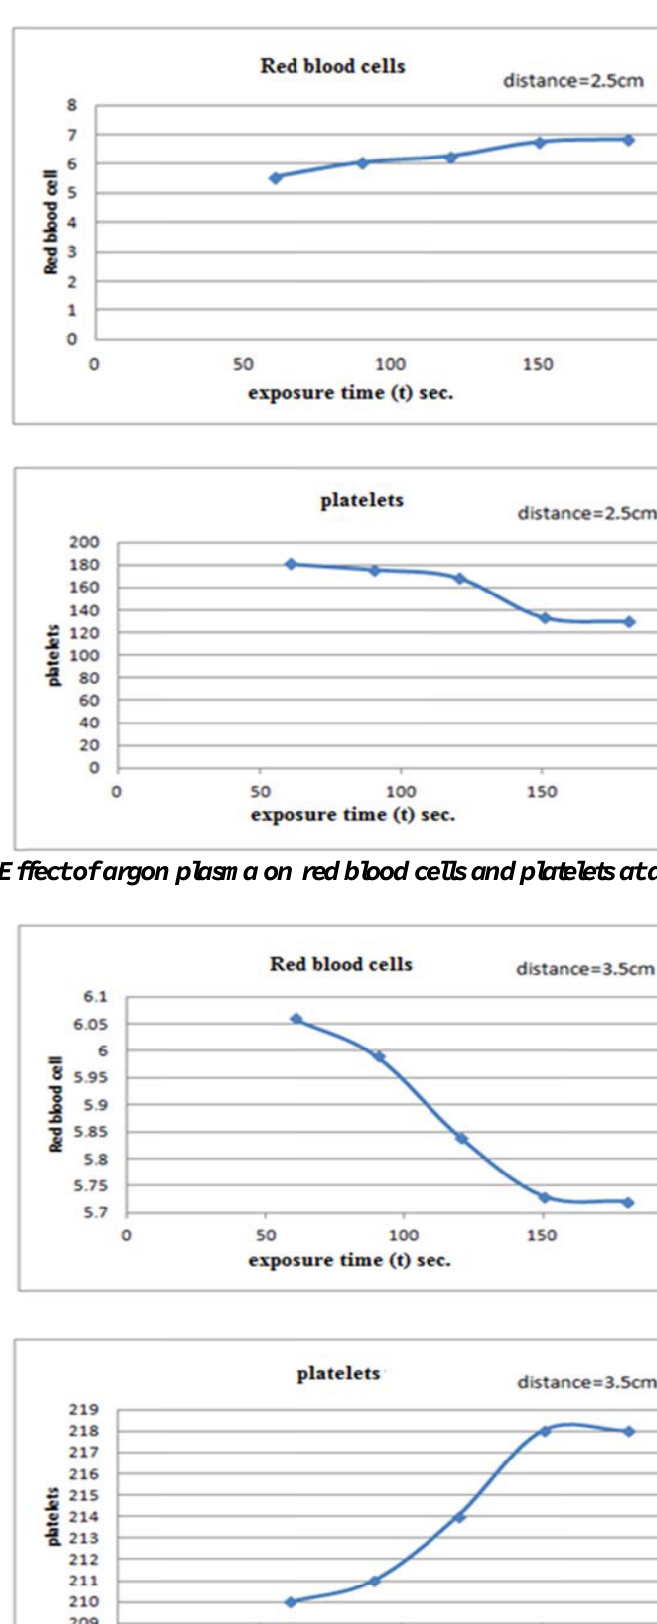
Fig. 6: The ef effect of Arg on plasma o on Red blood d cells and pl latelets at dis istance